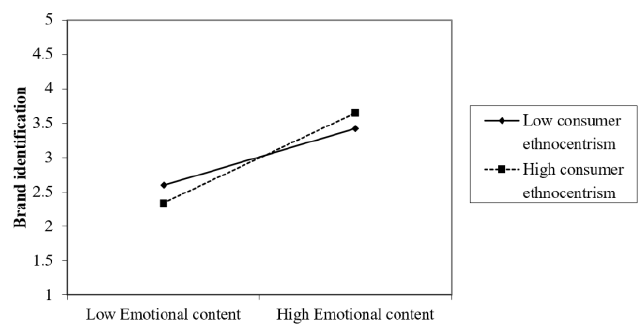
Figure 6: The moderating effect of consumer ethnocentrism on the relation between emotional content and brand